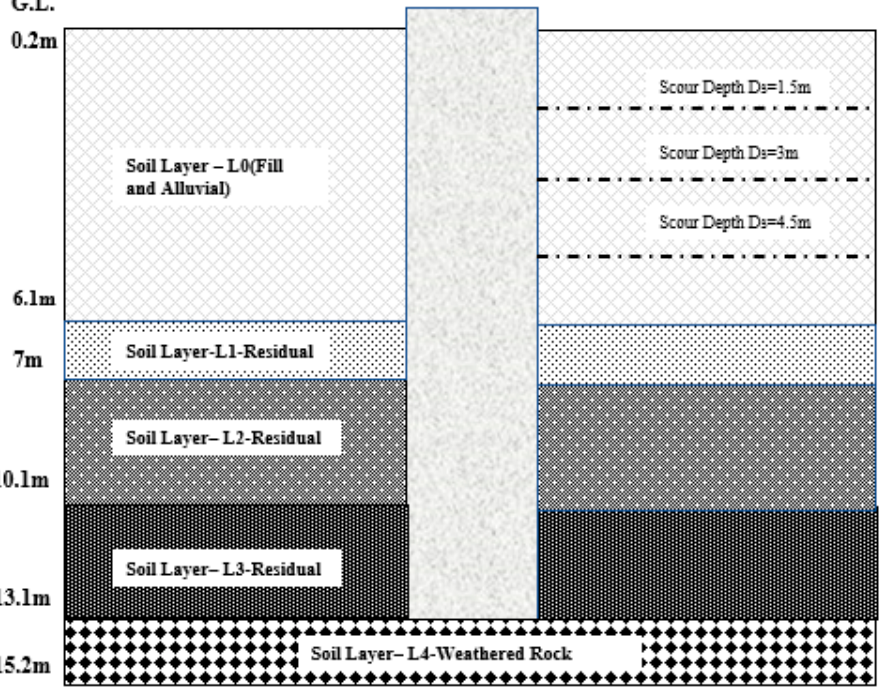
Figure 6. Schematic of soil profile and scour depths for the Phillips Road bridge pier. Table 1. Properties of different soil layers at the study site (Phillips Road bridge, UNC